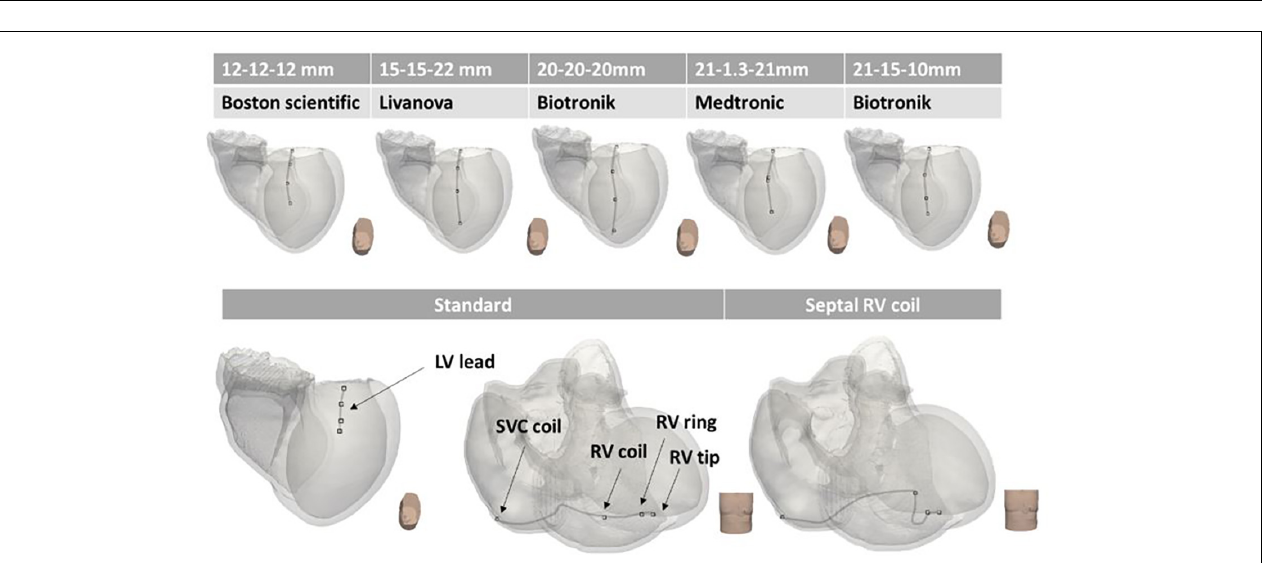
FIGURE 8 | Variations in CIED configurations. Different CIED LV configurations according to different manufacturers (Boston Scientific, Livanova, Biotronik, and Medtronic) are shown on the top panels. The standard configuration of RV and LV leads is illustrated on the bottom left, and the septal RV coil configuration is shown on the bottom right. The main difference between the various configurations is the inter-electrode distance (reported above the manufacturers’ names).